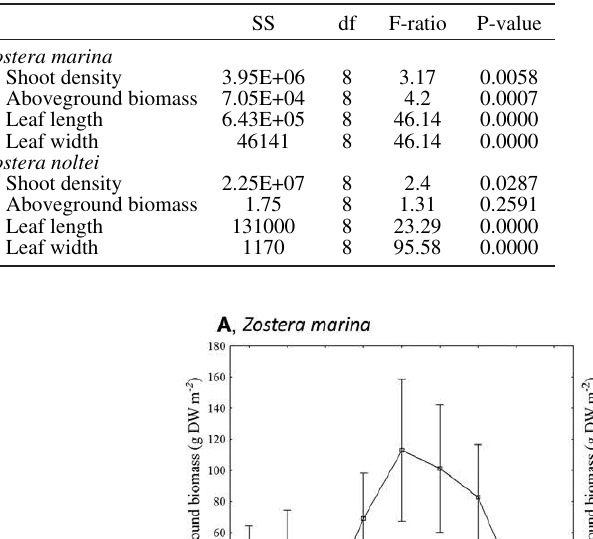
Table 2. – The effects of months on shoot density (no. shoots m –2 ), aboveground biomass (g DW m –2 ), leaf length (cm) and leaf width (cm) in the Zostera marina and Zostera noltei beds. Effects are ana- lysed using one-way ANOVA (n=9/months; <0.0001).